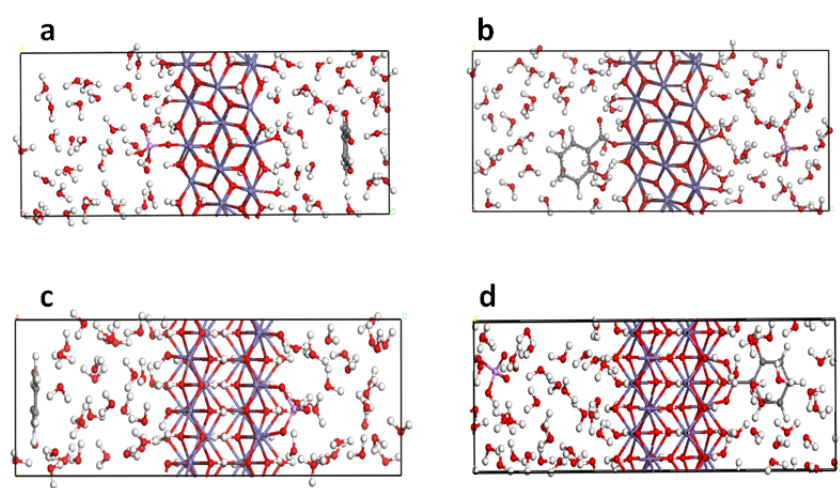
Figure 2. Models used to estimate ∆ E ads for the exchange reaction of phosphate with salicylate on the goethite (210) ( a , b ) and (101) ( c , d ) surfaces.